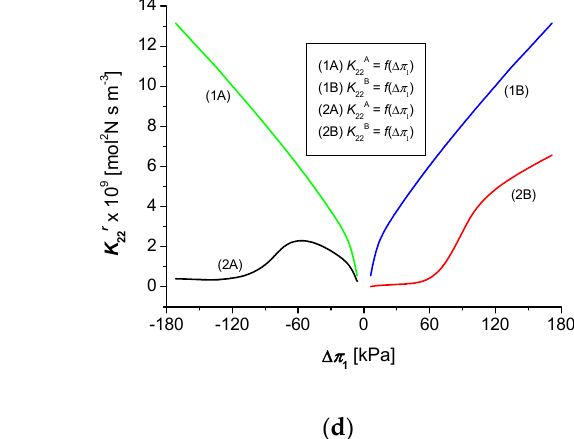
( i , j ∈ {1, 2, 3}, r = A, B) as functions of glucose osmotic pressure difference ij ( a ), K r and K r ( b ), K r ( c ), K r ( d 22 11 12 21 13